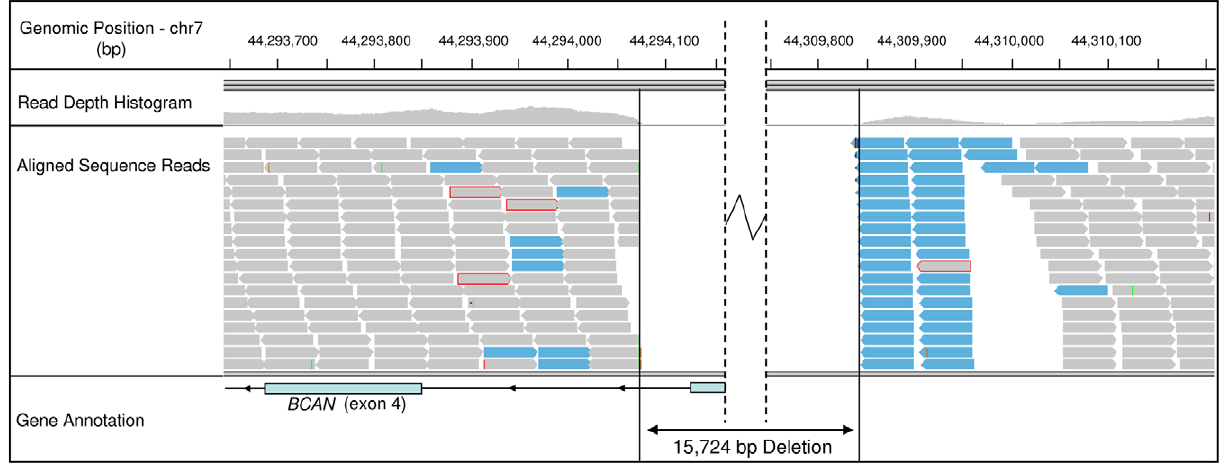
Figure 2. Sequence read alignments for an EF case, spanning the 5 9 region of the BCAN gene. Grey bars represent correctly aligned sequence reads. Reads with a red perimeter indicate that the mate has not been aligned for the read pair. Blue bars represent reads that have been flagged for inconsistent insert size; indicative of a genomic deletion.